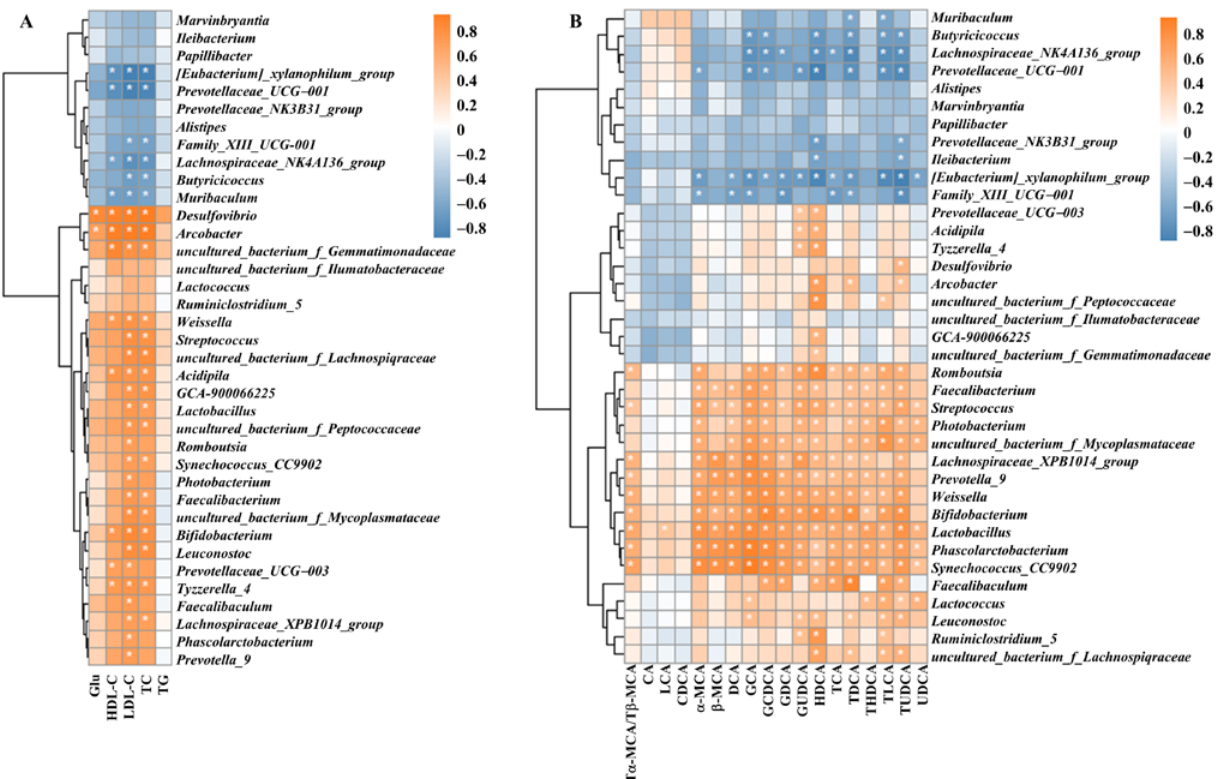
Figure 9. Spearman rank correlation analysis. ( A ) Spearman rank correlation analyses between intestinal microbiota and serum biochemical parameters, n = 4–5 per group. ( B ) Spearman rank correlation analyses between intestinal microbiota and bile acids in the cecum and colon, n = 4–5 per group. Red indicates positive correlation coefficients, and blue indicates negative correlation coefficients. Significant correlations are indicated by * p < 0.05.